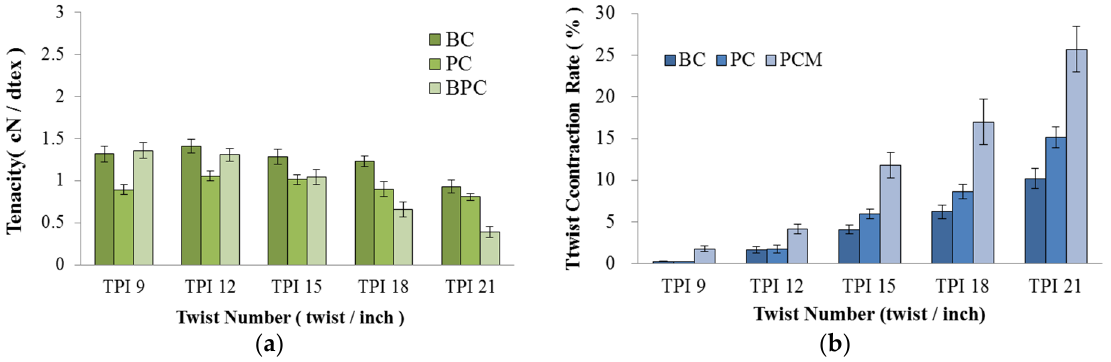
Figure 4. Tensile tenacity ( a ) and twist contraction ratio ( b ) of ring-spun yarns with different twist number (9, 12, 15, 18, and 21 per inch (TPI)).